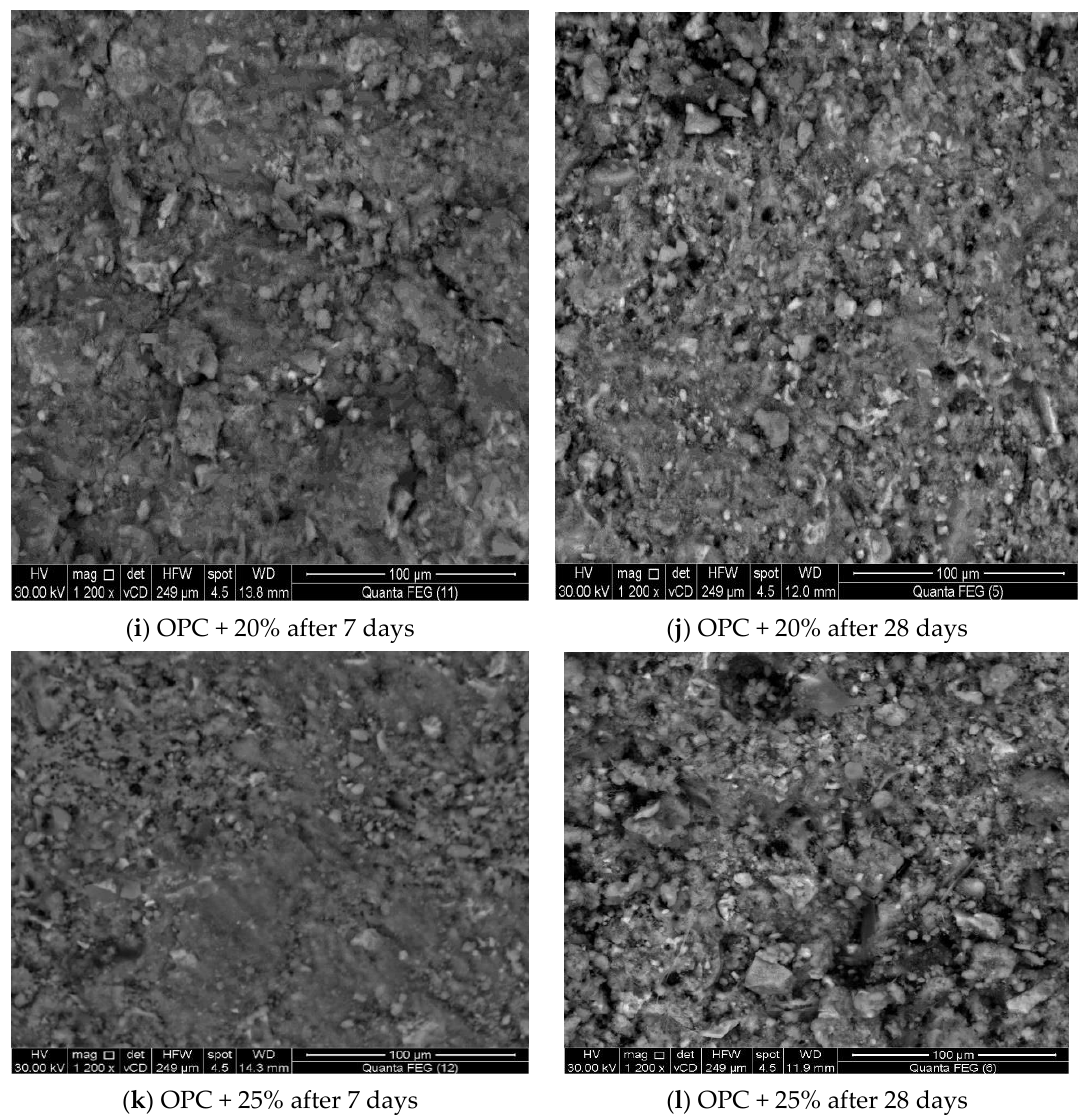
Figure 6. SEM micrographs of the OPC–CMW blended cement pastes at all curing times.